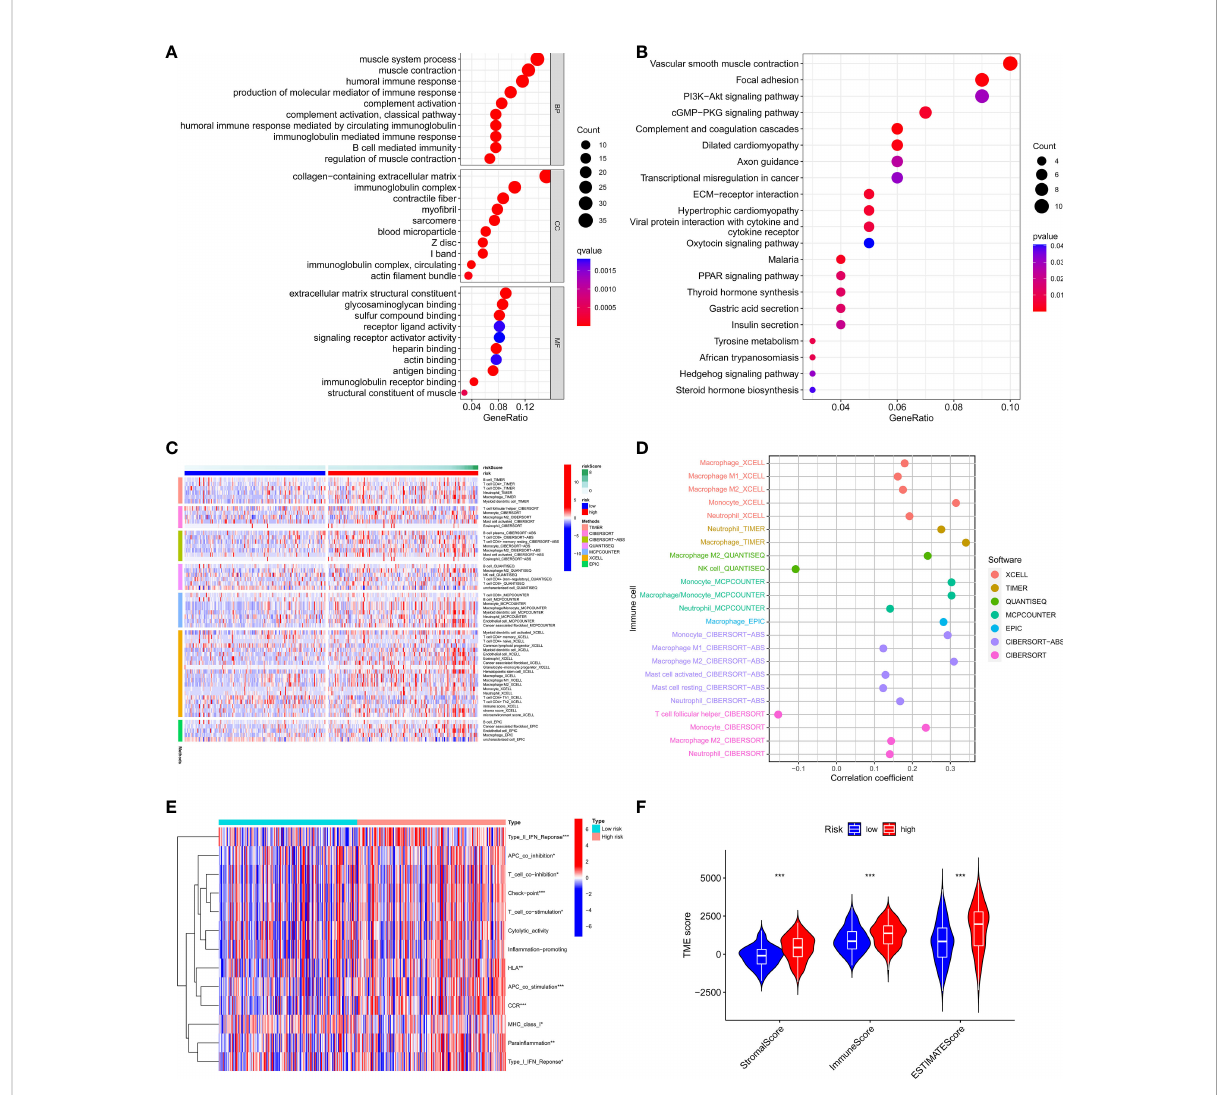
FIGURE 6 Relationship between the risk model and tumor immune microenvironment. (A, B) GO, and KEGG analysis of differentially expressed genes between high-risk and low-risk groups. (C, D) The in fi ltration status of immune cells of patients with different risk patterns. (E) Immune function differences of patients with different risk patterns. (F) The score of tumor immune microenvironment in different risk groups. *p < 0.05, **p < 0.01, and ***p <